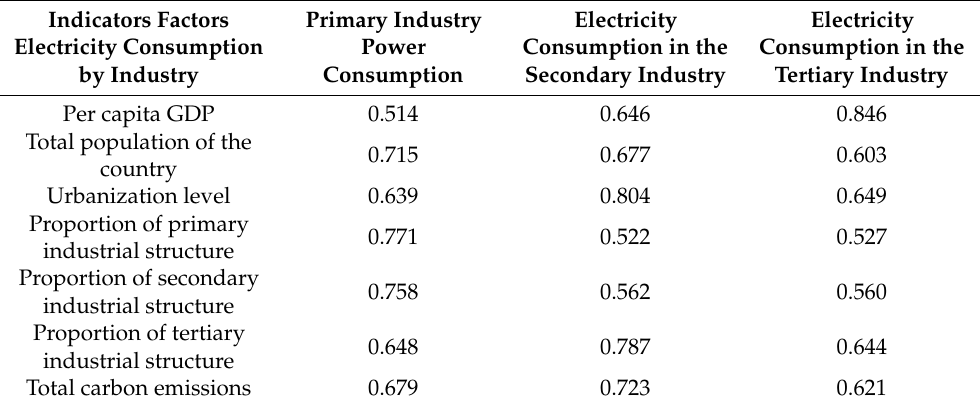
Table 3. Gray correlation analysis of China’s socio-economic factors and power consumption of primary, secondary, and tertiary